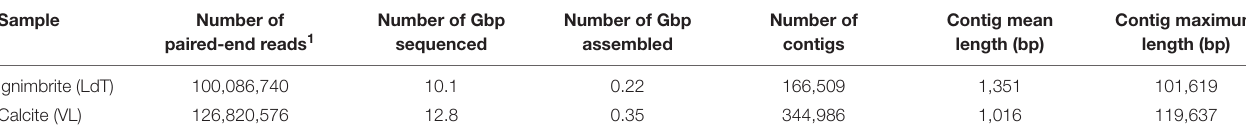
TABLE 2 | Number of sequence reads, Gbp of sequences, and contigs statistics for the calcite and ignimbrite metagenomes. Sample Number of Number of Gbp paired-end reads 1 sequenced